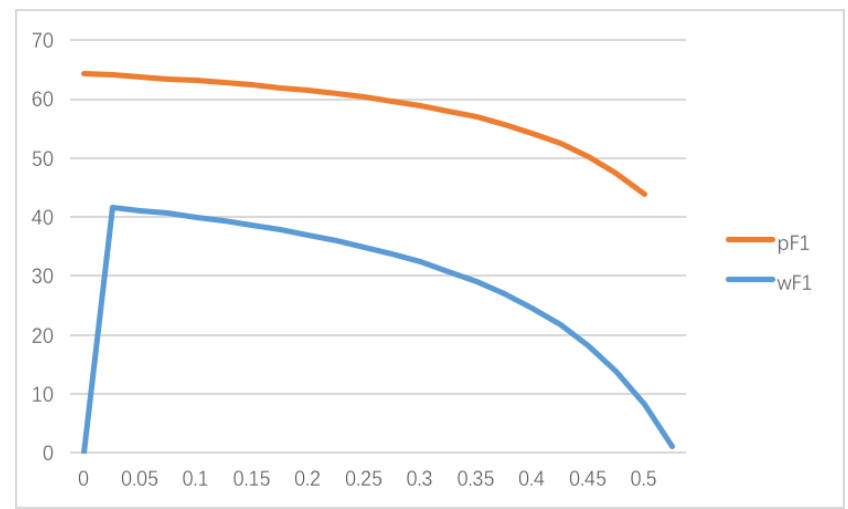
Figure 1. Impact of θ on the pricing policy when only the supplier concerns about fairness.